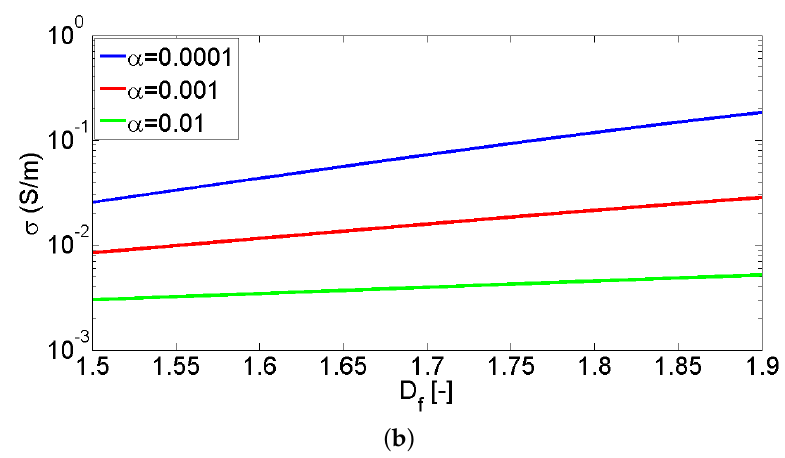
Figure 5. The variation of σ with the fracture aspect ratio β and the fractal dimension of the fracture sizes D f predicted from Equation (25) for three values of α (0.0001, 0.001 and 0.01) with representative values of σ w = 5 × 10 − 2 S/m, Σ s = 1 × 10 − 9 S, F = 20 and w max = 200 × 10 − 6 m. ( a ) D f is fixed at 1.7. ( b ) β is fixed at 0.001.